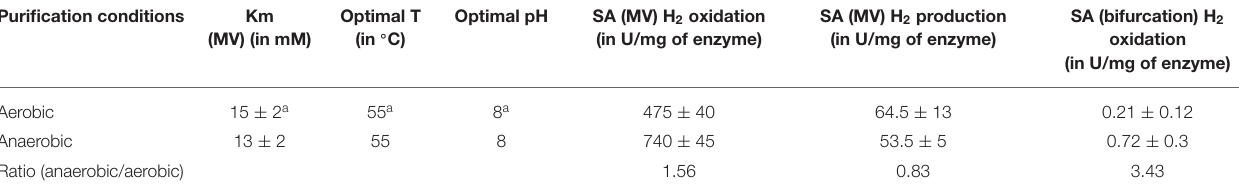
TABLE 1 | Comparison of catalytic properties of Hnd purified either under aerobic or anaerobic conditions. Purification